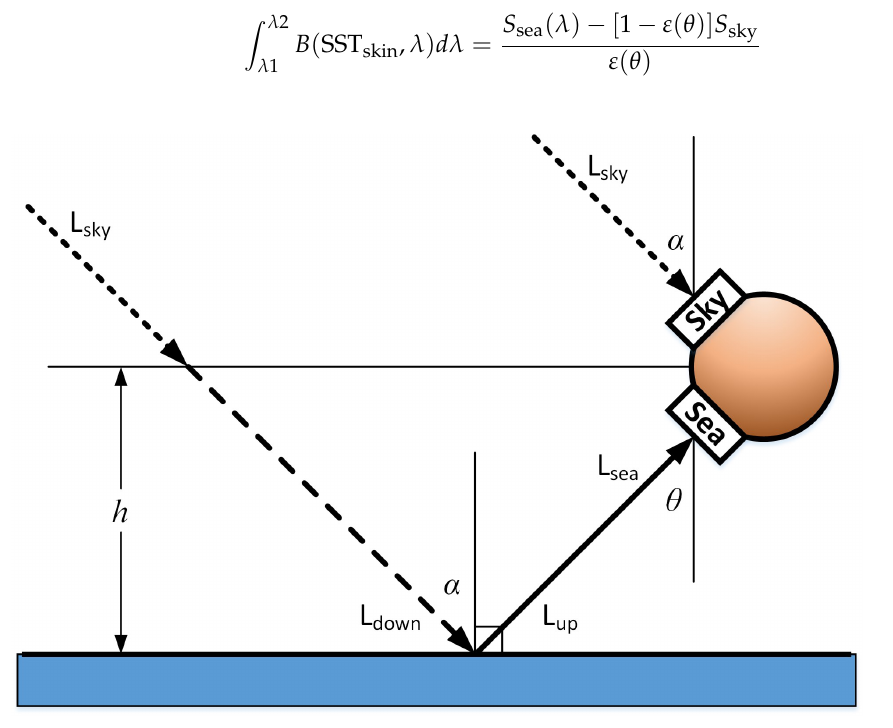
Figure 3. Radiation component of SST